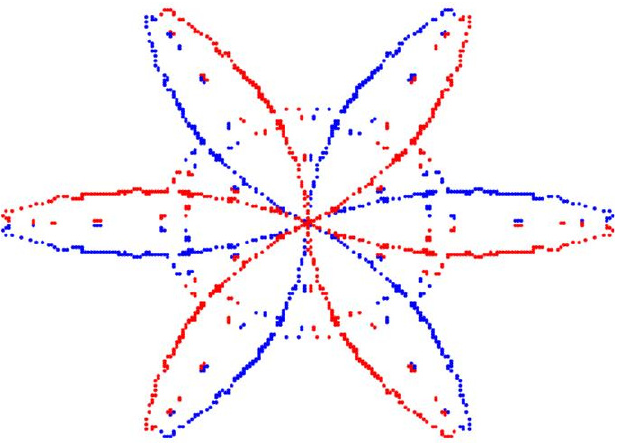
Figure 20. A normal PV module .